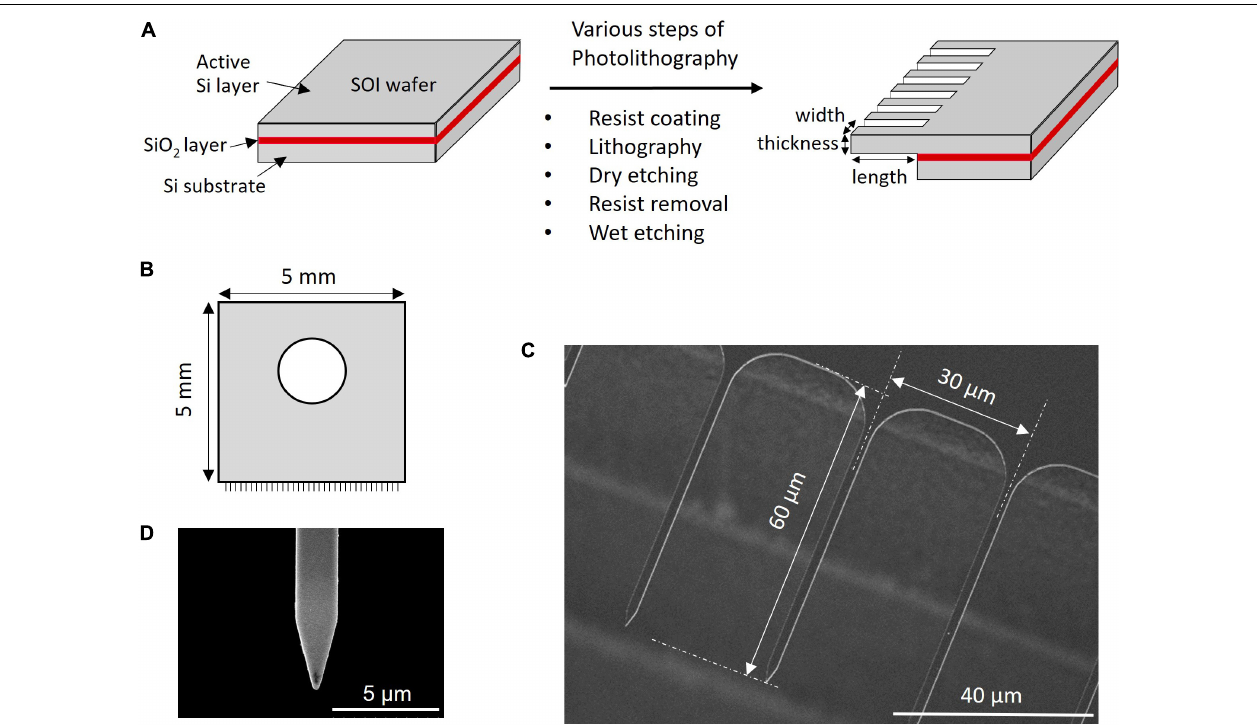
FIGURE 1 | Microneedle array preparation and SEM image. (A) Steps involved in the fabrication of MNA. (B) Schematics of the MNA. SEM image of (C) array and (D) single